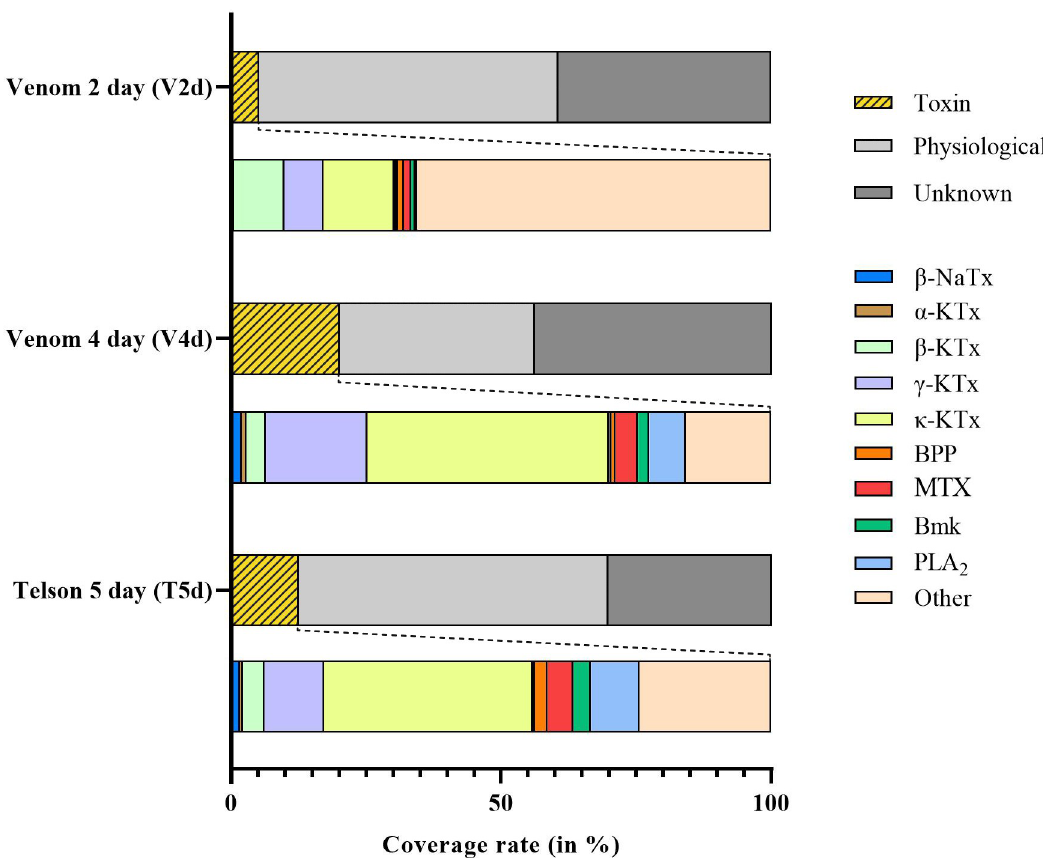
Fig 2. Relative expression levels of transcripts in the venom gland transcriptomes at different timepoints. The graphs show expression rates for venom gland transcriptomes two days after start of venom replenishment (V2d) and four days after the start of venom replenishment (V4d) relative to the whole telson transcriptome five days after the start of venom replenishment (T5d). In the upper bar graphs the transcripts are labelled as “toxin”, “physiological” and “unknown” and are shown as a percentage of total expression. The lower graphs represent the relative expression levels across toxin families within the “toxin” transcripts in the venom gland transcriptomes. Abbreviations: NaTx (sodium-channel binding toxin); KTx (potassium-channel binding toxins); ClTx (chlorotoxin); BPP (bradykinin-potentiating peptide); MTX (Maurotoxin); BmK ( Buthus martensii Karsch-toxin); PLA 2 (phospholipase A 2 ). Note: Some toxins are found at such low expression rates that these differentiated from the bar graphs, therefore these are not represented in the legend. These include α -NaTx, calcium-channel binding toxin and Kunitz-type toxin. Host defense proteins were classified under